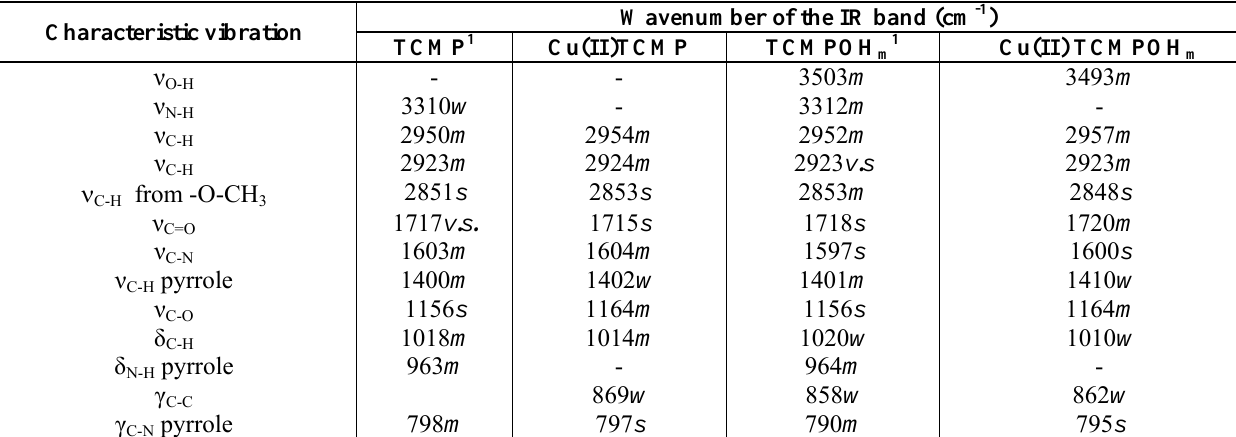
Table 1. Characteristic IR vibrations of the free base porphyrins and their Cu(II) complexes (KBr pellet).